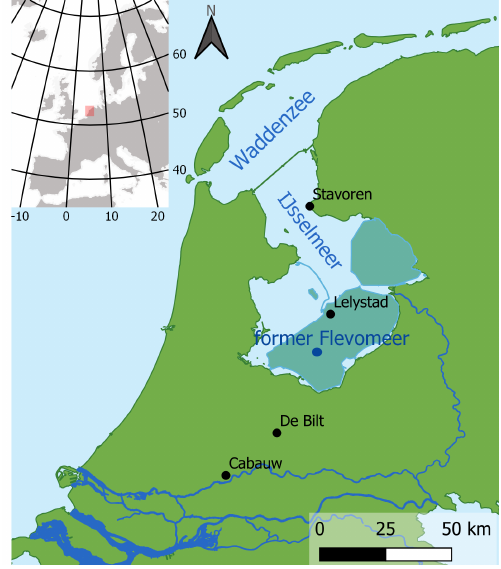
Figure 2. Overview of the study area and locations of the observa- tion